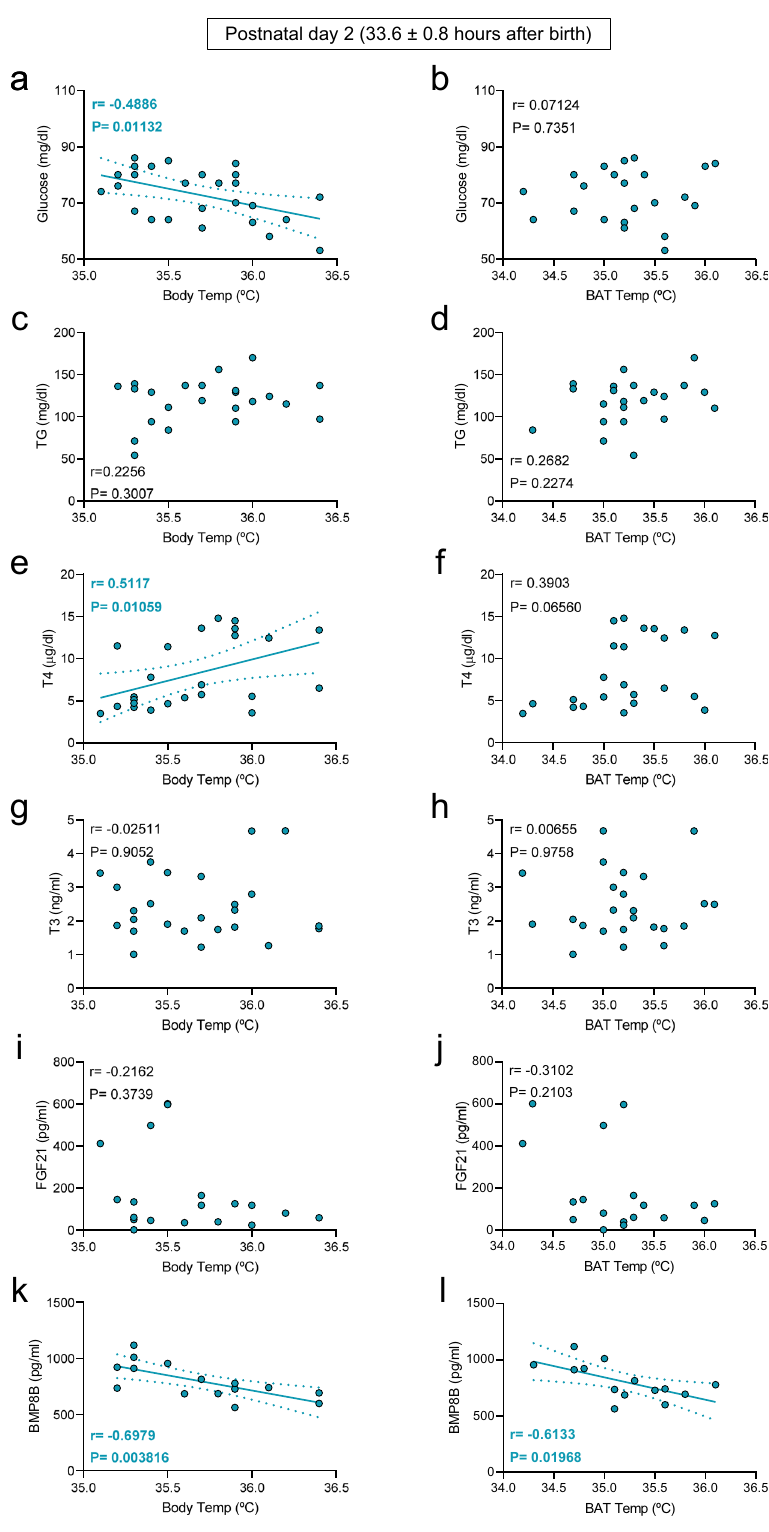
Fig. 6 Correlations between body and BAT temperatures and circulating parameters in cold exposed 2-day old newborns. Correlation between body temperature ( a , c , e , g , i , k ) and BAT temperature ( b , d , f , h , j , l ) in cold exposed newborns at postnatal day 2. Number of newborns: a 26, b 25, c 23, d 22, e 24, f 23, g 25, h 24, i 19, j 18, k 15, l 14. Association analysis was performed by two-sided Pearson ’ s test or Spearman ’ s test; regression line with 95% con fi dence interval was added when correlation was signi fi cant. Source data are provided as a Source data fi le.